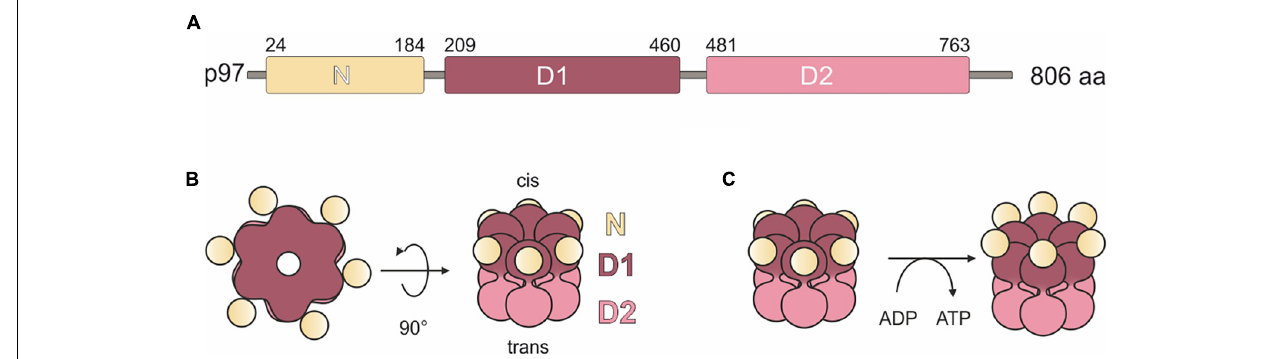
FIGURE 1 | Domain organization and model of H. sapiens p97. (A) p97 domain organization. N, N domain (yellow); D1, ATPase domain D1 (purple); D2, ATPase domain D2 (pink). Numbers indicate amino acid positions. (B) Schematic representation of the structure of the p97 homohexamer. Each monomer comprises a globular N domain (N) depicted in yellow and two ATPase domains, D1 (purple) and D2 (pink), forming two stacked rings. Surrounded by the rings, a central pore forms, which extends from the cis side (D1 domain) through the entire protein to the trans side (D2 domain). (C) Conformational states of the N domains are dependent on the nucleotide bound state of the D1 domains. Left: bound ADP induces down-conformation. Right: bound ATP induces